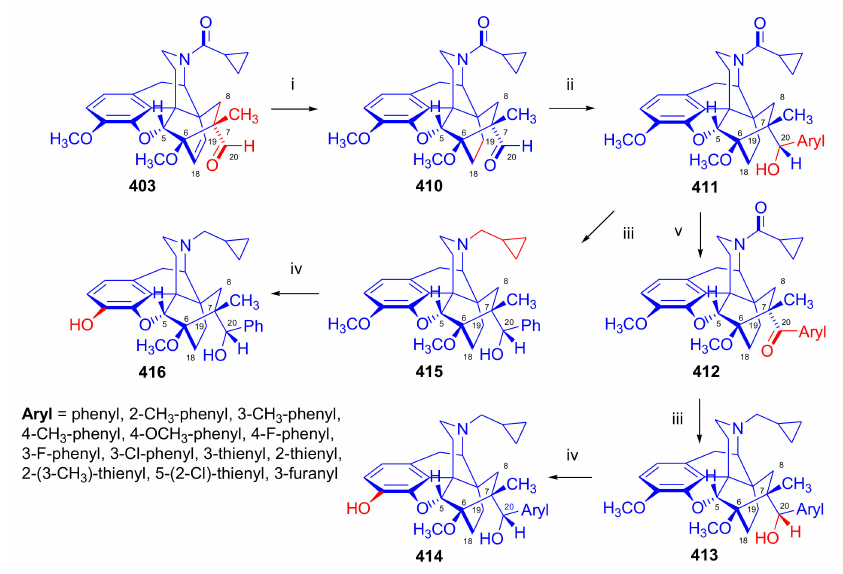
Figure 104. Synthesis of 7 β -methyl-20-aryl-18,19-dihydro-orvinol analogues. Reagents and conditions :